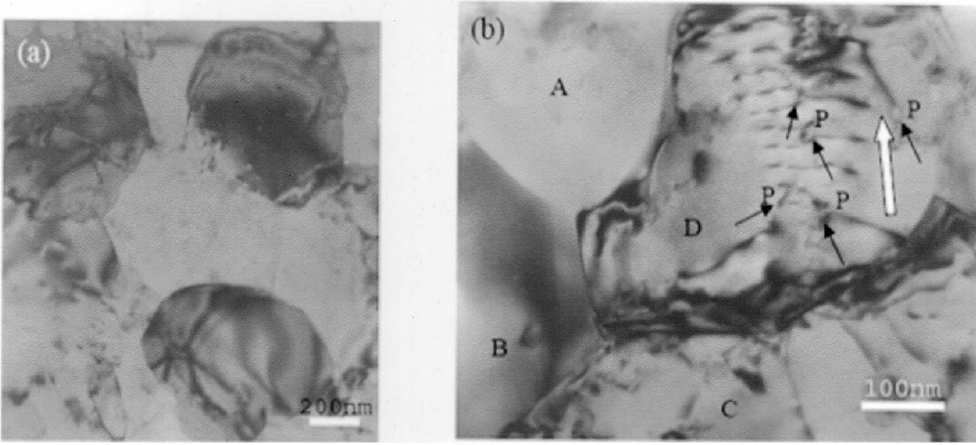
Figure 17. TEM micrograph of crept samples showing ( a ) dislocation free grains (T = 648 K and τ = 23 MPa); ( b ) the presence of dislocations in only few grains (T = 623 K and t = 19.2